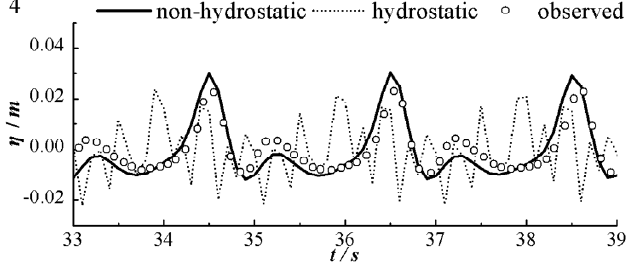
Figure 10. Simulated η by the non-hydrostatic (solid line) and hydrostatic model (dotted line); experimental data (circled) from Stations 1–4.